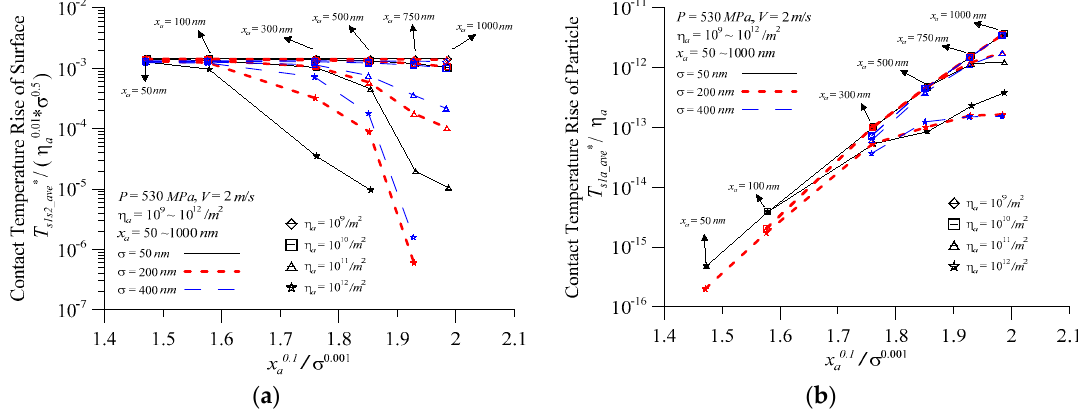
Figure 10. Variation of the contact temperature rise with the ratio of the particle diameter to surface roughness at various surface roughness values and the area density of particles for ( a ) the surface; and ( b ) the particle.